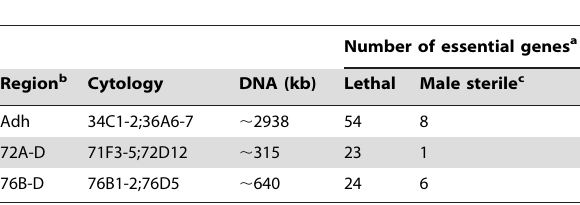
Table 1. DNA and essential genes in three autosomal